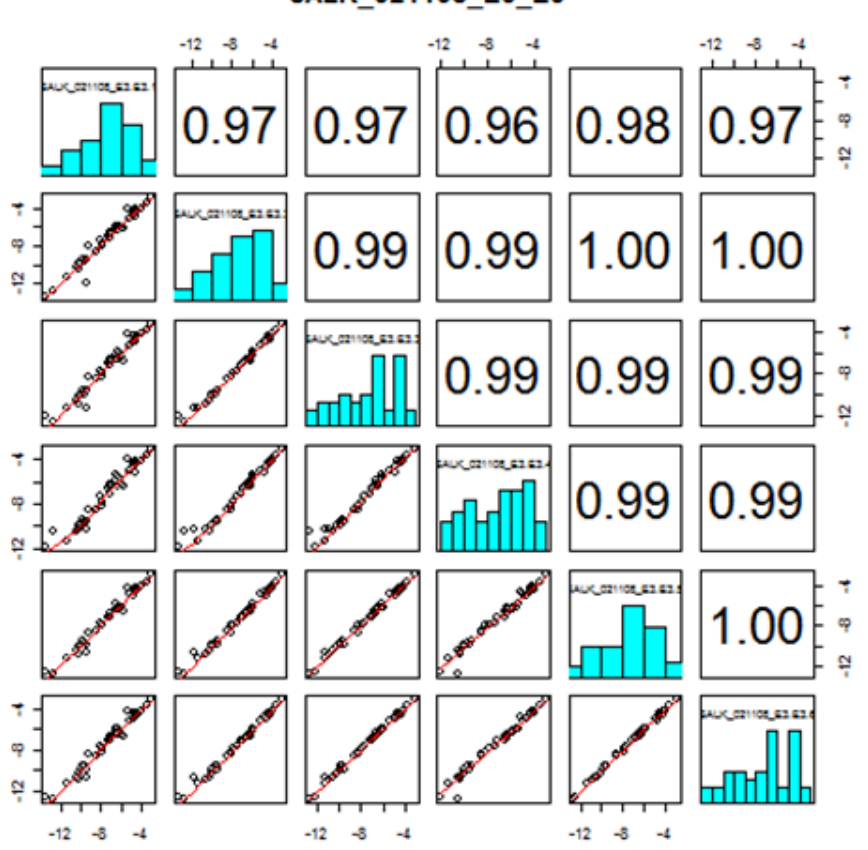
Figure S3. Replicate quality analysis plot for the amino acid profiling by UPLC-LC- MS/MS in the mutant stock SALK_021108 (AT1G52670). Instructions in how to interpret this plot can be found in the consortium web portal (Figure taken from www.PlantMetabolomics.com). The numbers in the upper right corner correspond to the correlation coefficients between replicates (ith row, jth column). The x (ith replicate) and y (jth replicate) coordinates of the scatterplots are the logarithms (base 2) of the ratio of the mean relative abundances ( μ ) of each amino acid in the wild-type (wt) versus mutant (mt) plant ( i.e. , log ( μ /u 2 mt wt